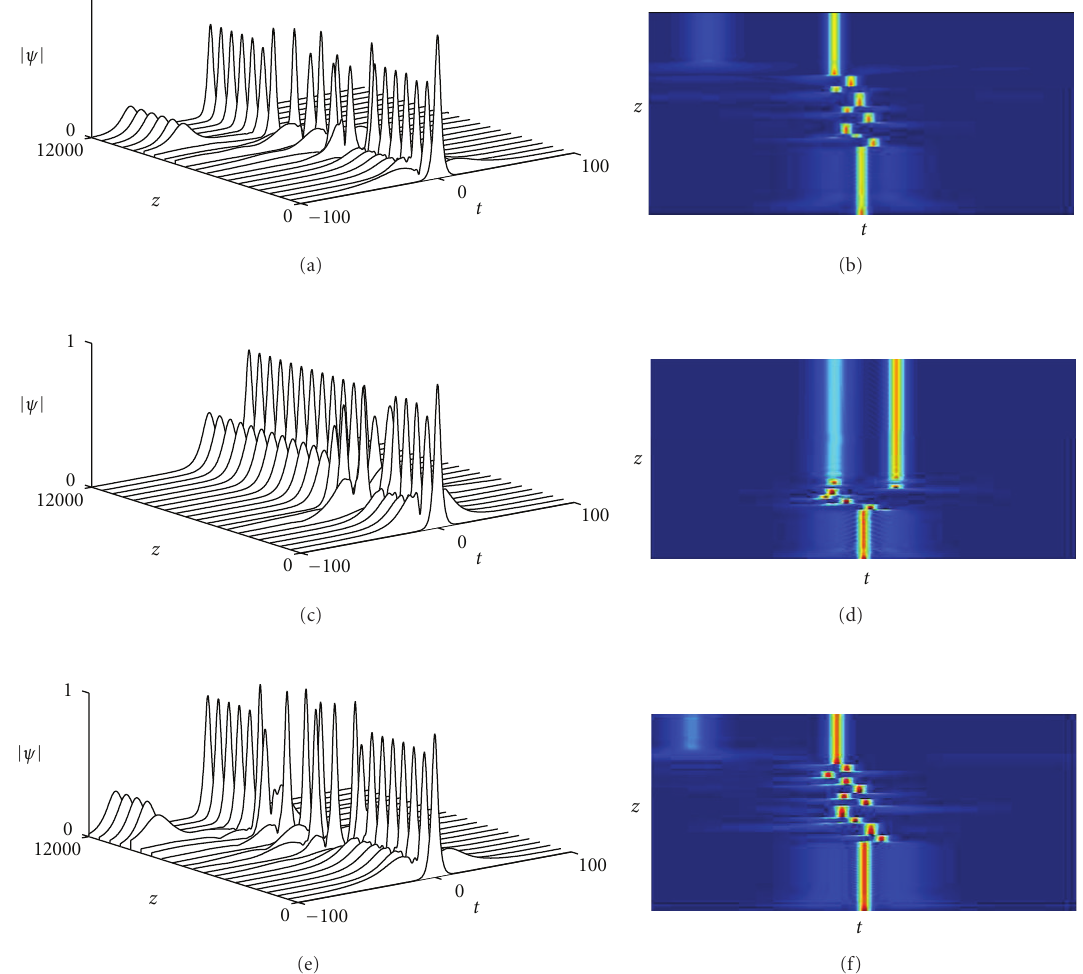
Figure 10: Periodic evolution observed in the full governing equations ((a) and (b), g 0 = 2 . 27), CQGLE ((c) and (d), g 0 = 2 . 2), and SGLE ((e) and (f), g 0 = 2 . 2). The simulated evolutions are shown in (a), (c), and (e) and the corresponding pseudocolor plots are shown in (b), (d), and (f). The rest of the parameters in the simulations are D = − 0 . 4, α 1 = 0 . 1 π , α 2 = 0 . 554 π , α 3 = 0 . 23 π , α p = 0 . 43 π , K = 0 . 1, Γ = 0 . 1, e 0 = 1, and τ = 0 . 2. The initial conditions in all the simulations are ψ (0, t ) = sech 0 . 5 t (from [29], 2011,